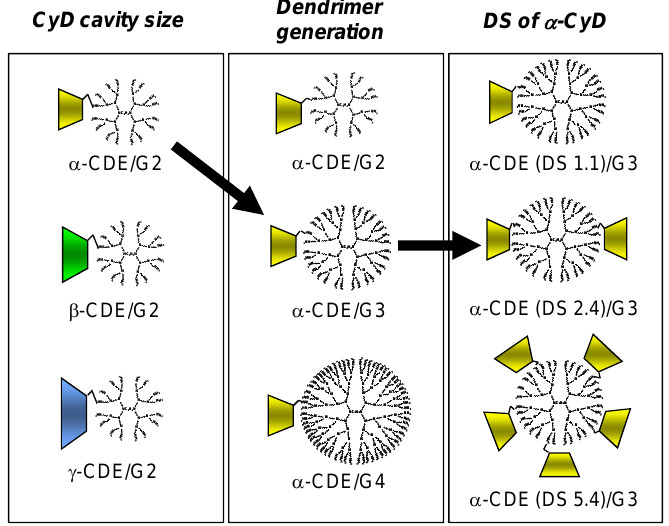
Figure 2. Optimization study of CDE as non-viral